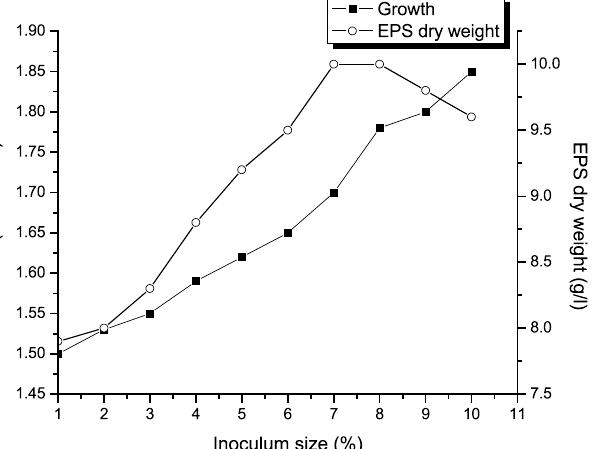
Fig. 6. Influence of initial inoculum dose on growth and EPS production by Halomonas sp. NASH. Fermentations were carried out in IRAM medium 4M NaCl at different inoculum dose of 1–10% (v/v) under continuous shaking (200 rpm) at pH and temperature of 9 and 37°C.